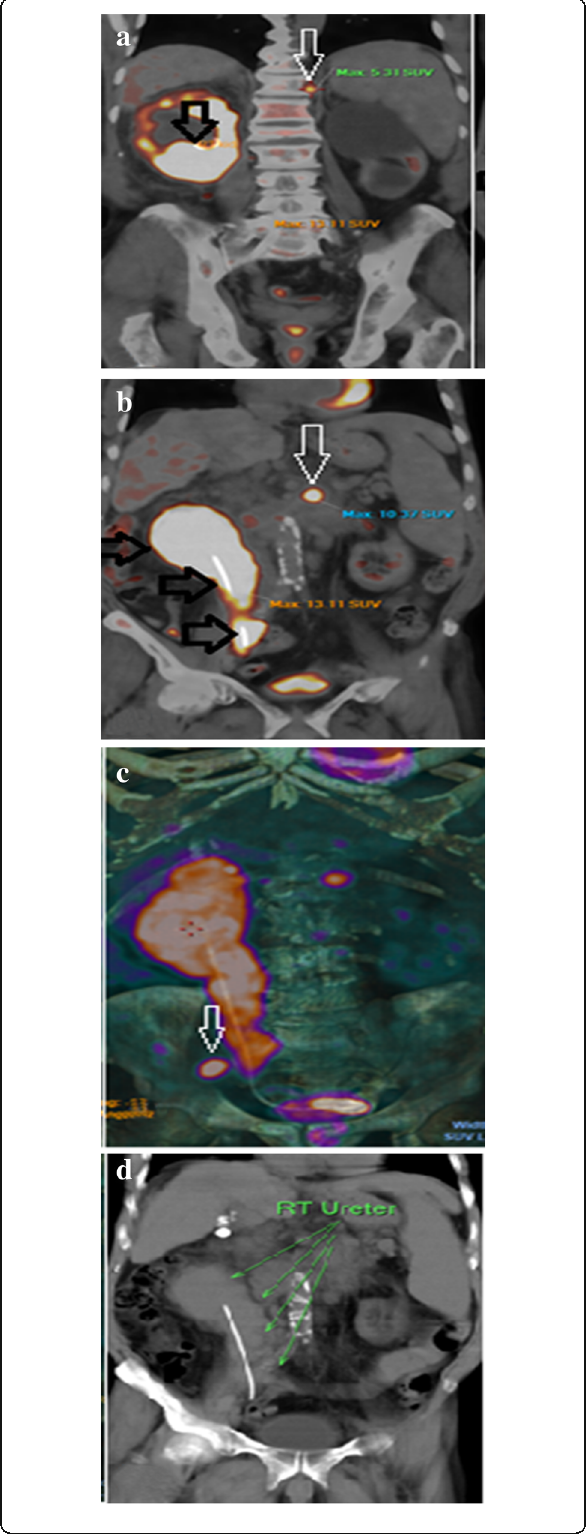
Fig. 7 RT renal and ureteric lymphoma: note intensely avid soft tissue mass lesion related to the lower pole of the right kidney and ureter. a , b PET CT images with corresponding 3D PET ( c ) and diagnostic component thick MIP ( d ), associated avid LT para aortic and LT retrocrural LNs (white arrows). Double J ureteric stent is